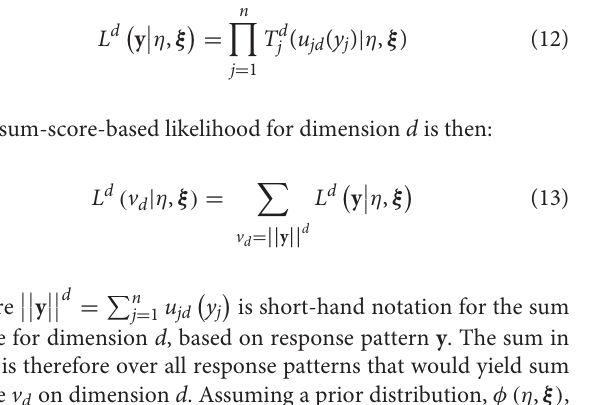
TABLE 7 | Accumulating sum score likelihoods.